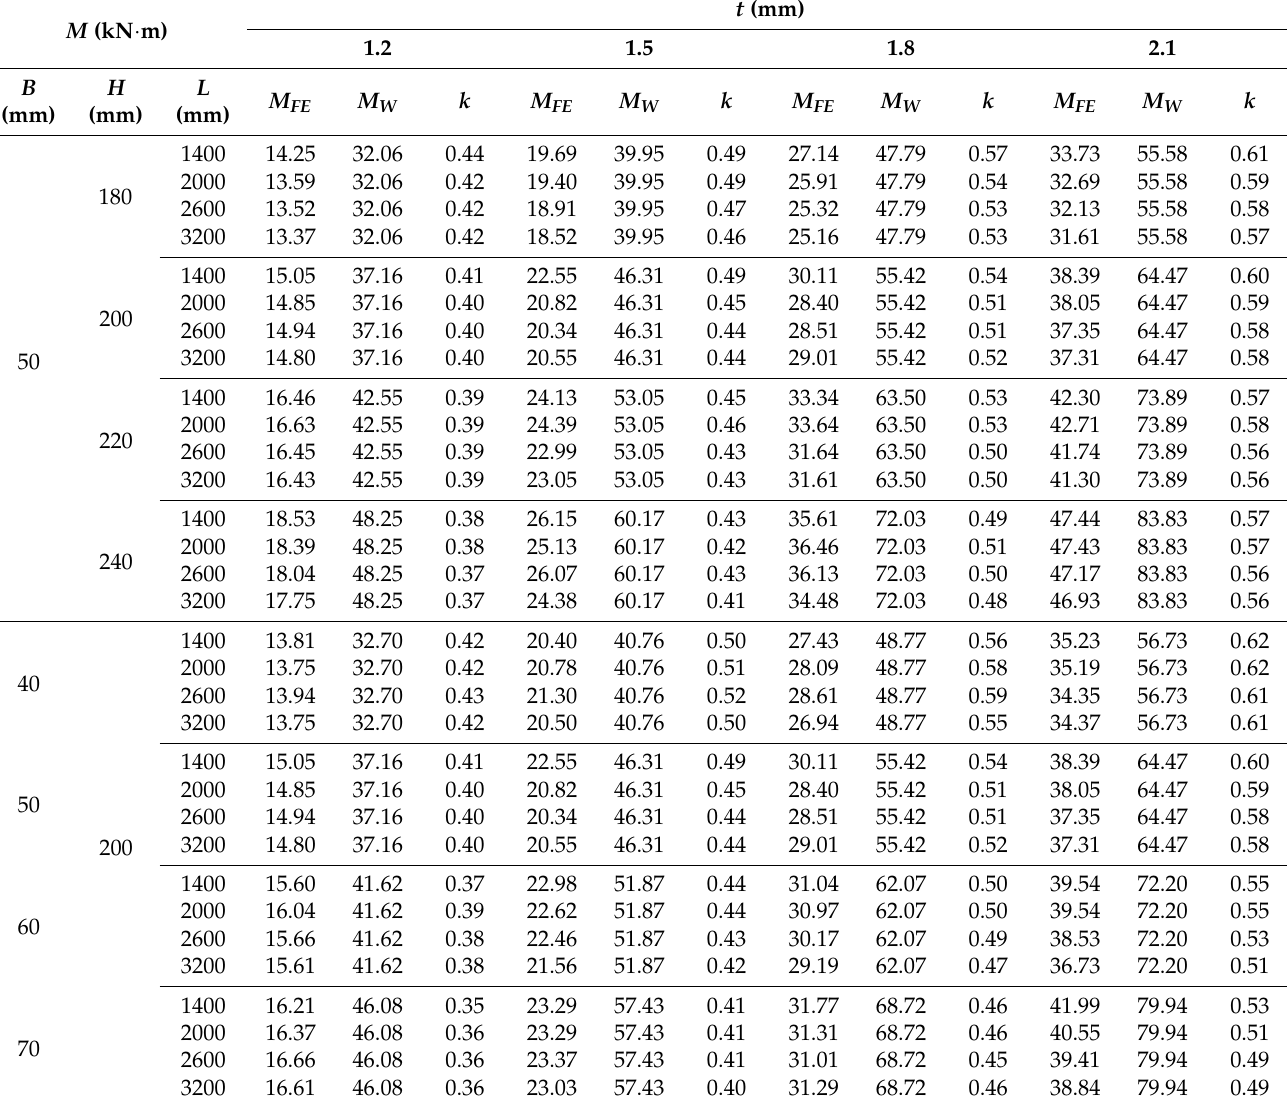
Table 5. Summary of the flexural moment capacities for K4